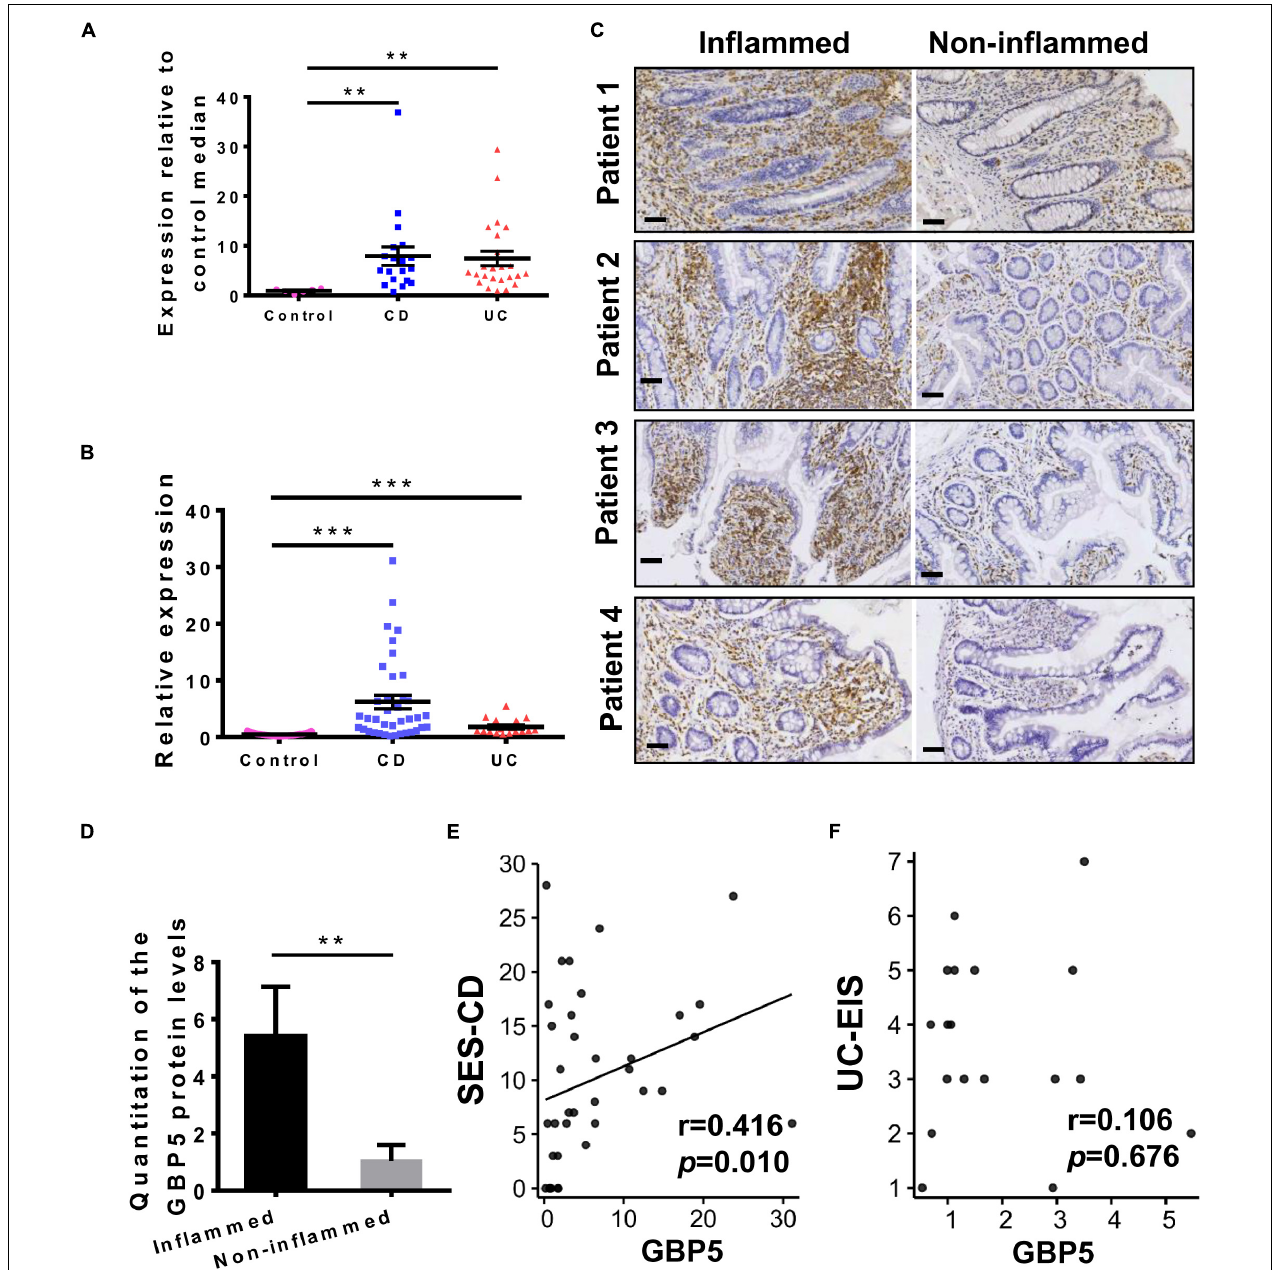
FIGURE 1 | GBP5 is highly expressed in the inflamed intestinal tissue of IBD patients. (A) Messenger RNA expression of GBP5 in the colonic mucosa of healthy controls ( n = 6), patients with Crohn’s disease (CD, n = 19), and ulcerative colitis (UC, n = 24). Data are from a microarray dataset generated from a European cohort. ** P < 0.01, Dunn’s multiple comparison test. (B) Quantitative RT-PCR analysis of GBP5 mRNA in colonic mucosa from a Chinese cohort including healthy controls ( n = 35), and patients with CD ( n = 38) and UC ( n = 17). *** P < 0.001, Dunn’s multiple comparison test. (C) Immunohistochemical staining of GBP5 in colonic mucosa from four representative patients with CD. Images of inflamed and non-inflamed sites from the same patient are compared side by side. Bar = 50 µ m. (D) Quantitation of the GBP5 staining in the inflamed and non-inflamed sites in (C) . ** P < 0.01, paired Student’s t -test. (E,F) Spearman’s correlation analysis of the mucosal GBP5 expression levels and endoscopic severities. GBP5 expression levels are from quantitative RT-PCR results. SES-CD, simple endoscopic score for Crohn’s disease; UC-EIS, ulcerative colitis endoscopic index of severity.